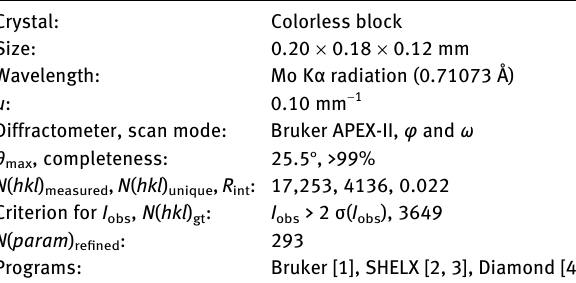
Table  : Data collection and